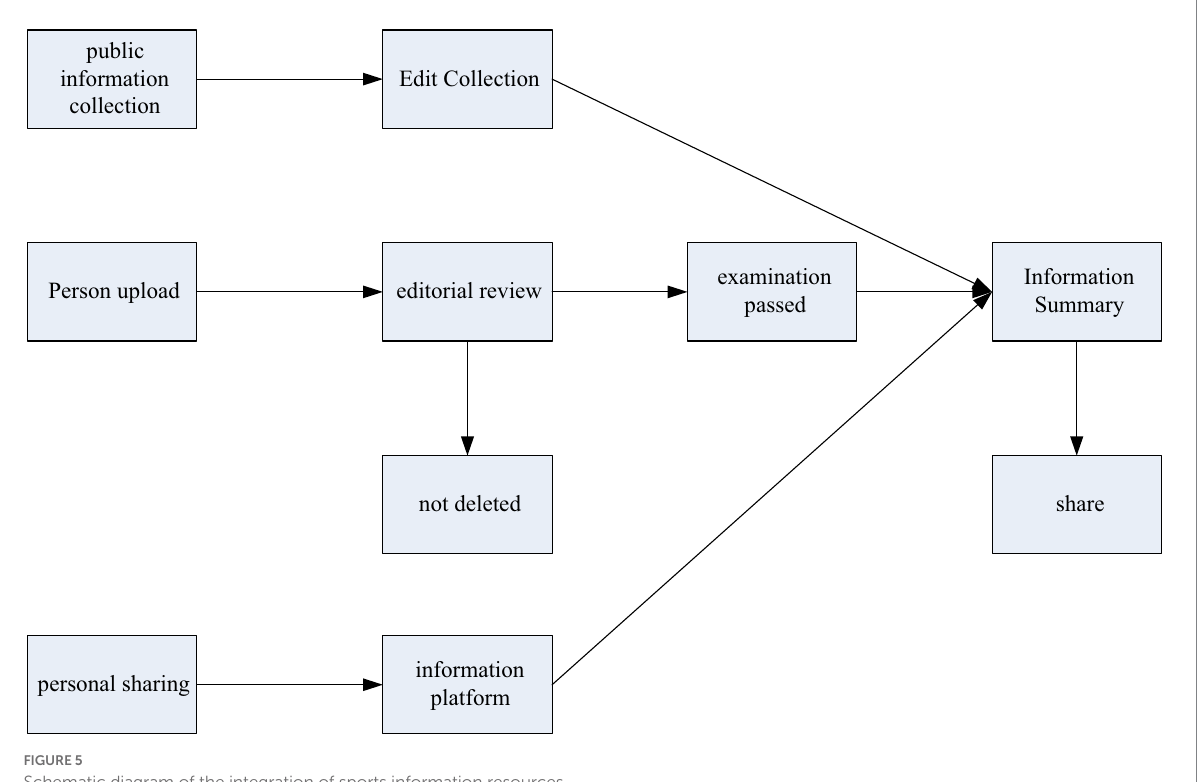
FIGURE 5 Schematic diagram of the integration of sports information